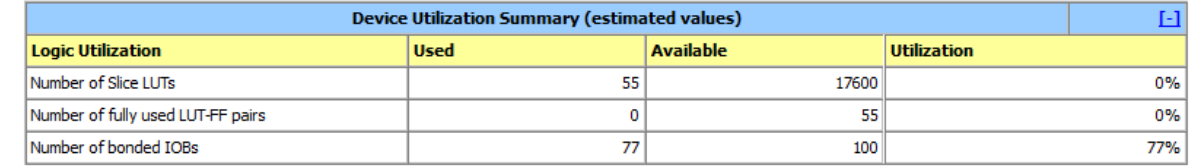
Figure 3. Design summary.